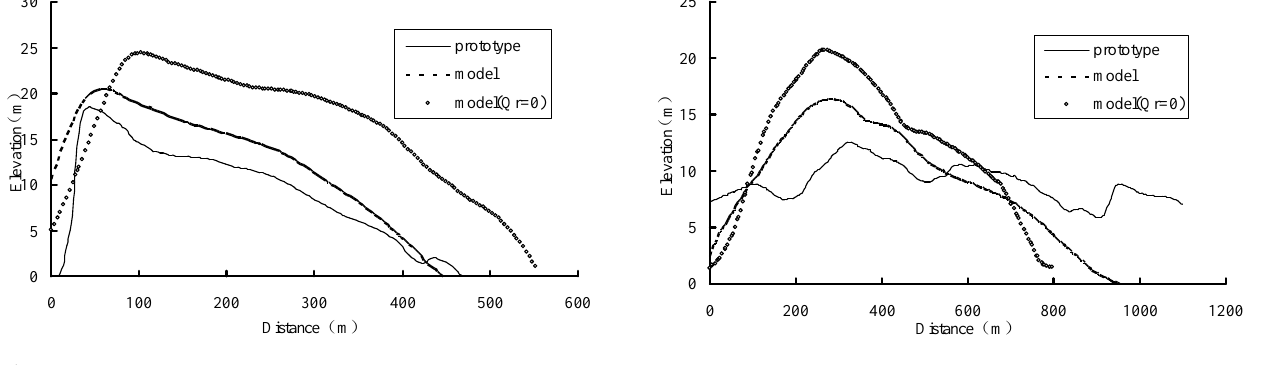
Figure 8. Transverse deposit profile Figure 9. Longitudinal deposit profile